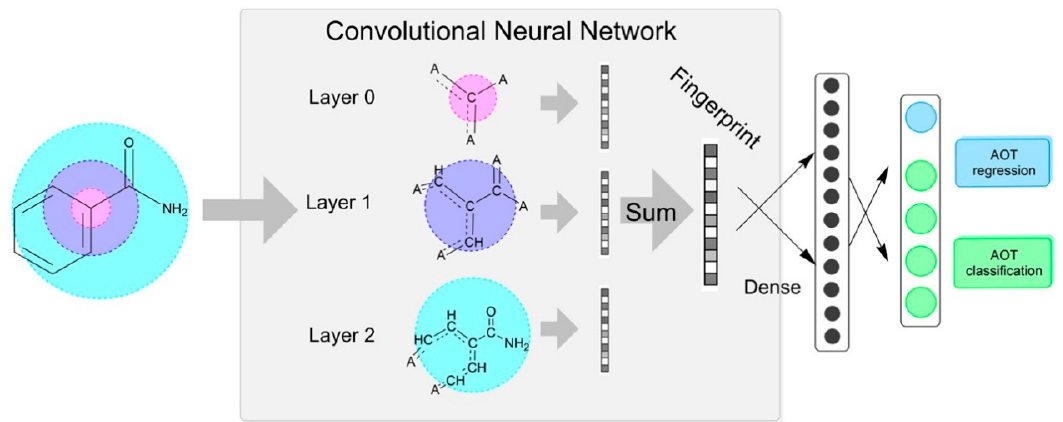
Figure 3. An acute oral toxicity prediction . The prediction starts from a chemical molecular structure in the simplified molecular-input line-entry system (SMILES) format, as an input to the MEG-CNN, where the pink, purple, and cyan circles represent the first, second, and third iterations, respectively. During each iteration, the chemical structure is processed by the convolutional kernel according to the atom degree to obtain the corresponding pre-fingerprint. All of the pre-fingerprints are integrated to generate the fingerprint, which was further processed to generate the deep-mined fingerprint. The deep-minded fingerprint was then tested by the regression model (the blue circle) and the multiclass/multitask models (the green circles)